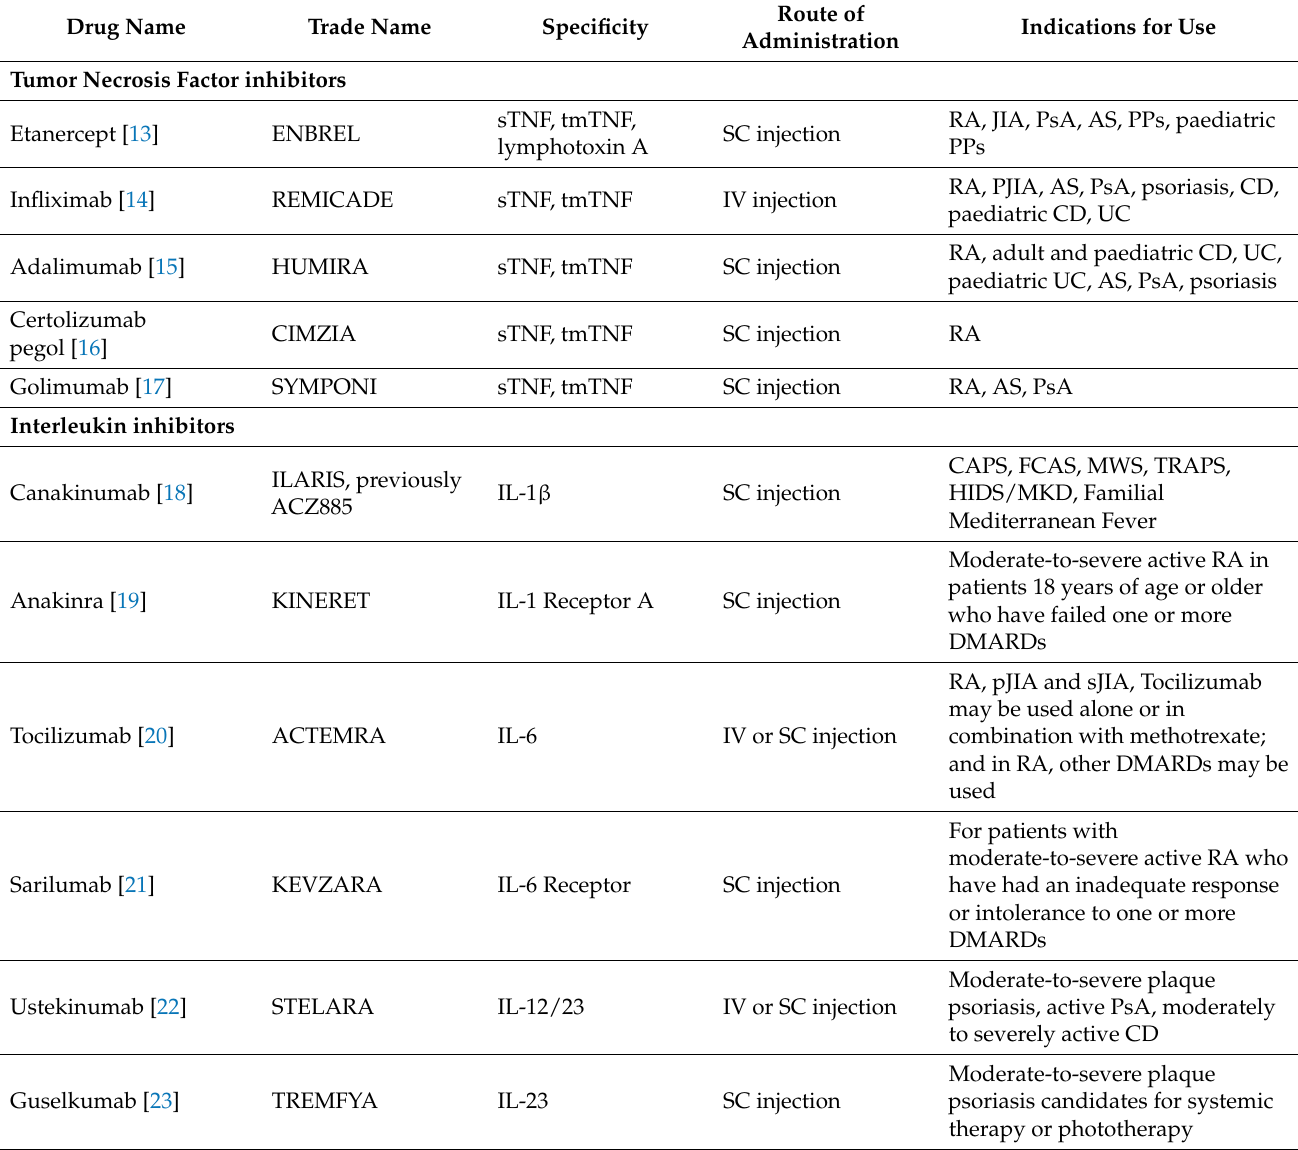
Table 1. List of biologic DMARD drugs and their indications for